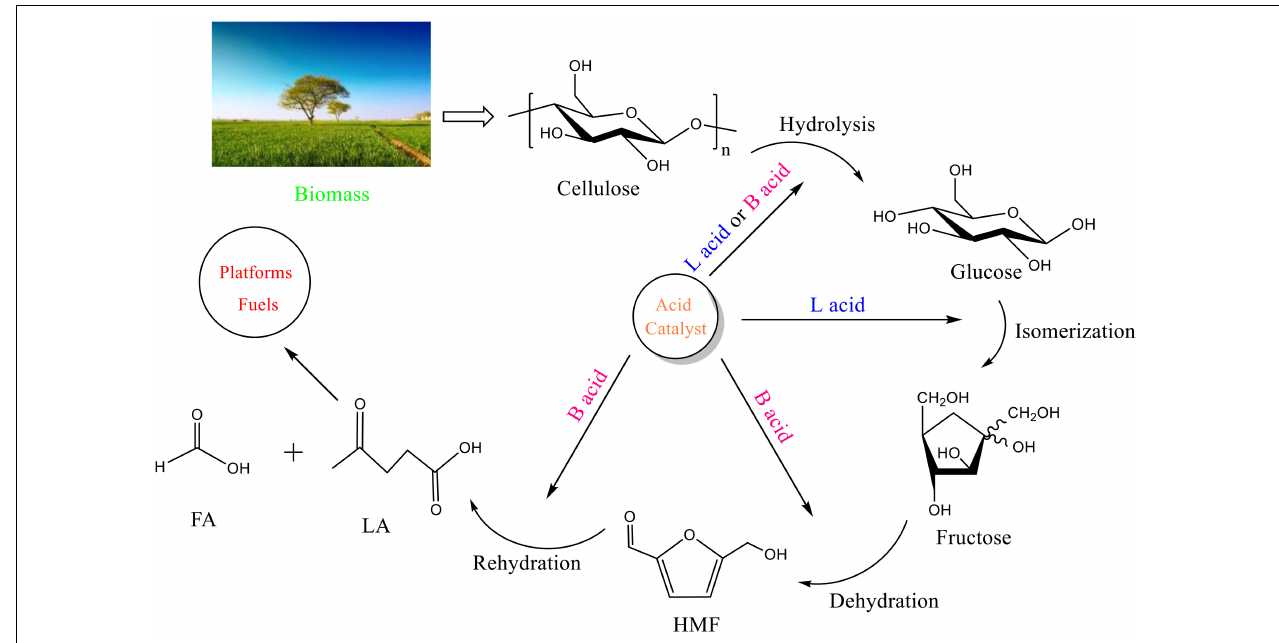
SCHEME 1 | Reaction pathway from cellulose to